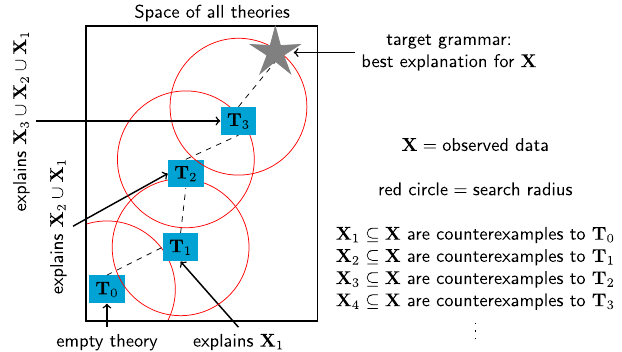
Fig. 3 | Inference method for Bayesian Program Learning. To scale to large programsexplaininglargecorpora,werepeatedlysearchforsmallmodi fi cationsto our current theory. Such modi fi cations are driven by counterexamples to the current theory. Blue:grammars. Red: search